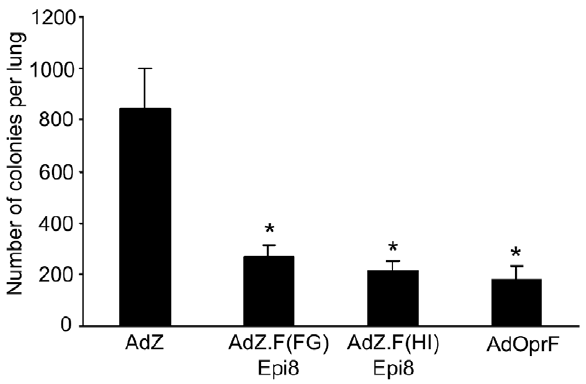
Figure 8. Protective anti- P. aeruginosa immunity induced by immunization with Epi8 fiber-modified Ad vectors. BALB/c mice were immunized via the intramuscular route with AdZ.F(FG)Epi8, AdZ.F(HI)Epi8, AdOprF and AdZ at a dose of 10 10 pu/mouse followed by boost immunizations after 2 and 5 wk. Eight weeks after immunization, mice were challenged with agar-encapsulated P. aeruginosa (4 6 10 6 cfu). Bacterial counts in lung homogenate were performed after 24 h. Data are shown as means 6 SEM of 5 mice/ group. * denotes p , 0.05, compared to AdZ-immunized mice.